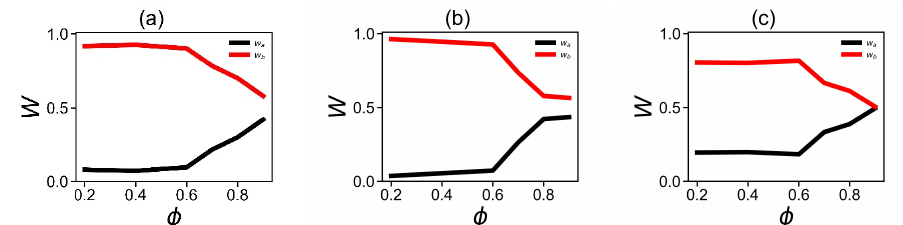
Figure 12. The dependencies of the fraction w a (black line) of all compact secondary structures ( α -helix-like) and the w b fraction (red line) of all extended ( β -helix-like) conformations versus the methanol fraction φ . ( a ) Fractions of corresponding secondary structures in the DGL1 backbone; ( b ) the fraction of corresponding structures in DGL2 side chains; ( c ) the fraction of corresponding structures in the DGL2 backbone.